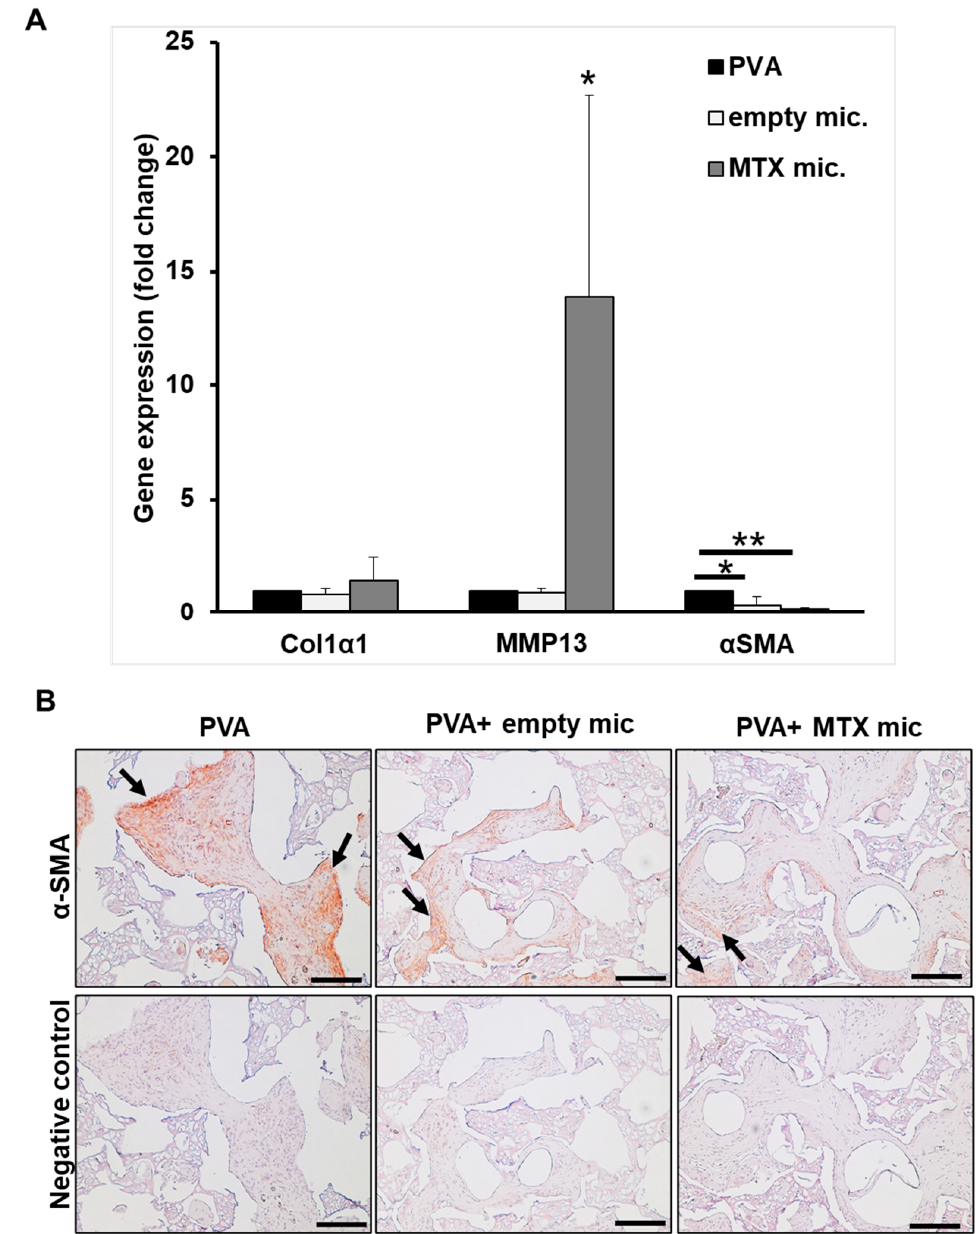
Figure 7. Col1 α 1, MMP-13, and α -SMA expression in rats after 62 days. ( A ) qPCR results revealed that MTX containing microspheres significantly increased the MMP-13 expression (13.9 ± 8.8-fold) in comparison with the PVA alone or empty microspheres. The expression of α -SMA decreased significantly in both empty and MTX microsphere-loaded PVAs compared to the PVA alone group. n = 3, * indicates statistical significance, * p < 0.05, ** p = 0.004. ( B ) Immunohistochemical (IHC) staining of samples revealed decreased α -SMA expression (Arrows), in PVA + MTX and PVA+ empty microspheres compared to the PVA alone group. Scale bar = 200 µ